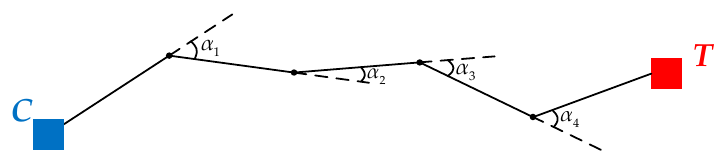
Figure 9. A certain actual trajectory of mobile robot. The black solid line represents the actual trajectory. The black dots represent the location where the robot recalculates the homing vector. α 1 , α 2 , α 3 and α 4 denote the offset angles.